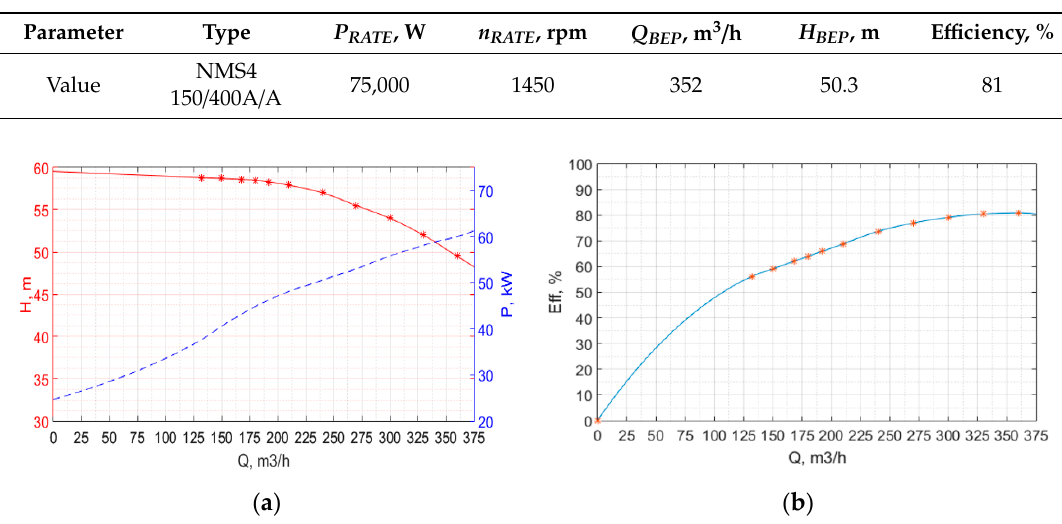
Figure 1. Pump interpolated curves and initial points: ( a ) Q - H curve of the pump and dependence of the pump power on water flow; ( b ) dependence of the pump efficiency on water flow.